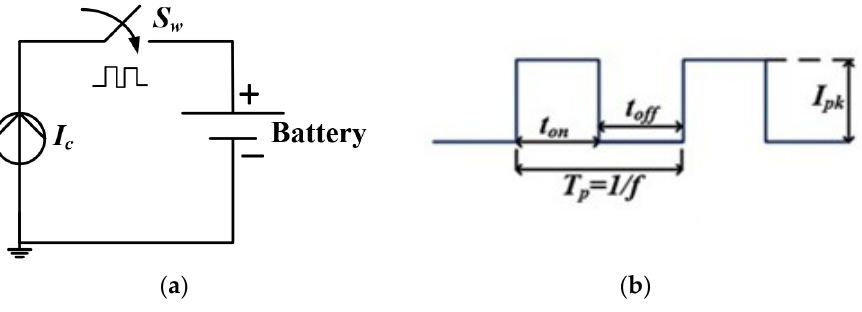
Figure 3 . ( a ) Pulse charging micromodel; and, ( b ) pulse waveform. Figure 3. ( a ) Pulse charging micromodel; and ( b ) pulse